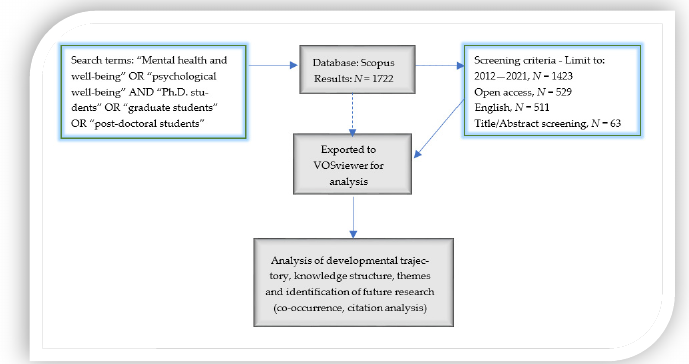
Figure 1. The Research